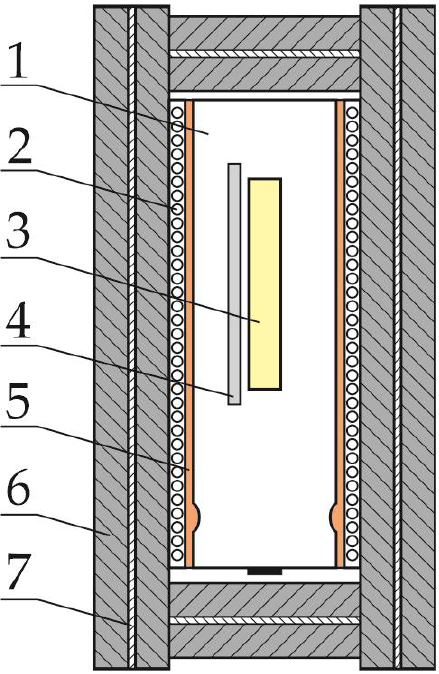
Figure 2. Scheme of the cell module. Number 1 — cell; 2 — resistant wire coil; 3 — RTD Sensor; 4 — thermocouple; 5 — electric insulation layer; 6 — fire-resistant non-woven fabric; 7 — metallized fabric.